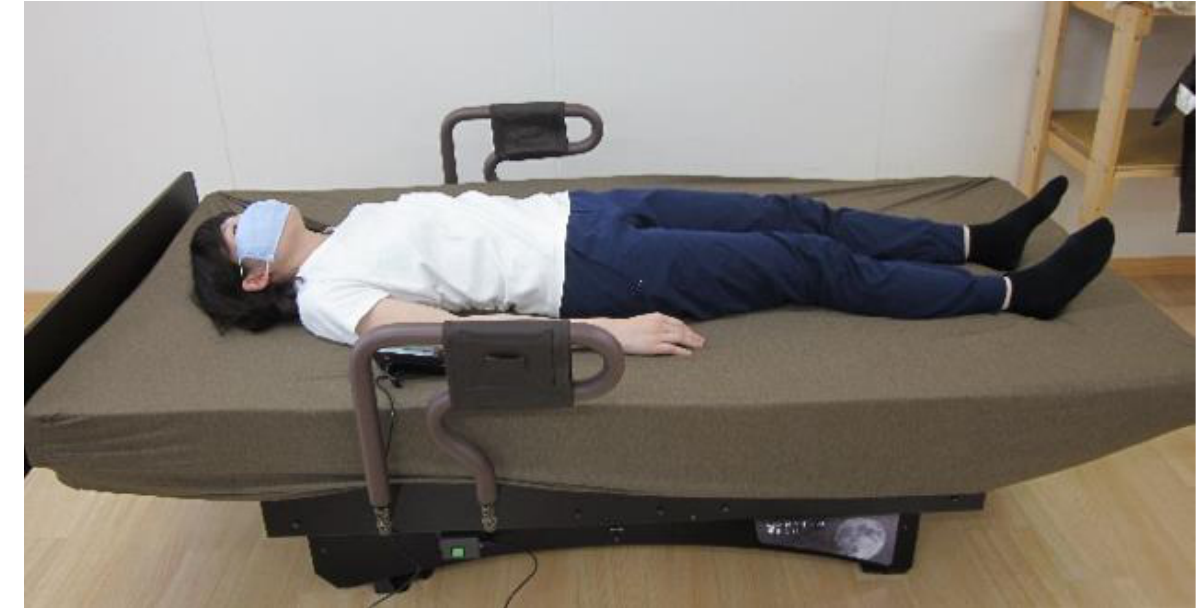
Figure 1. An electric sway bed (dimensions: 1900 × 900 × 500 mm (length × width × height)), powered by an electric motor, with seven sway speed settings. The motorized device was set to sway the student vertically by ±2 cm for a total of 4 cm. In this study, the level 2 (0.64 Hz) sway speed was used.